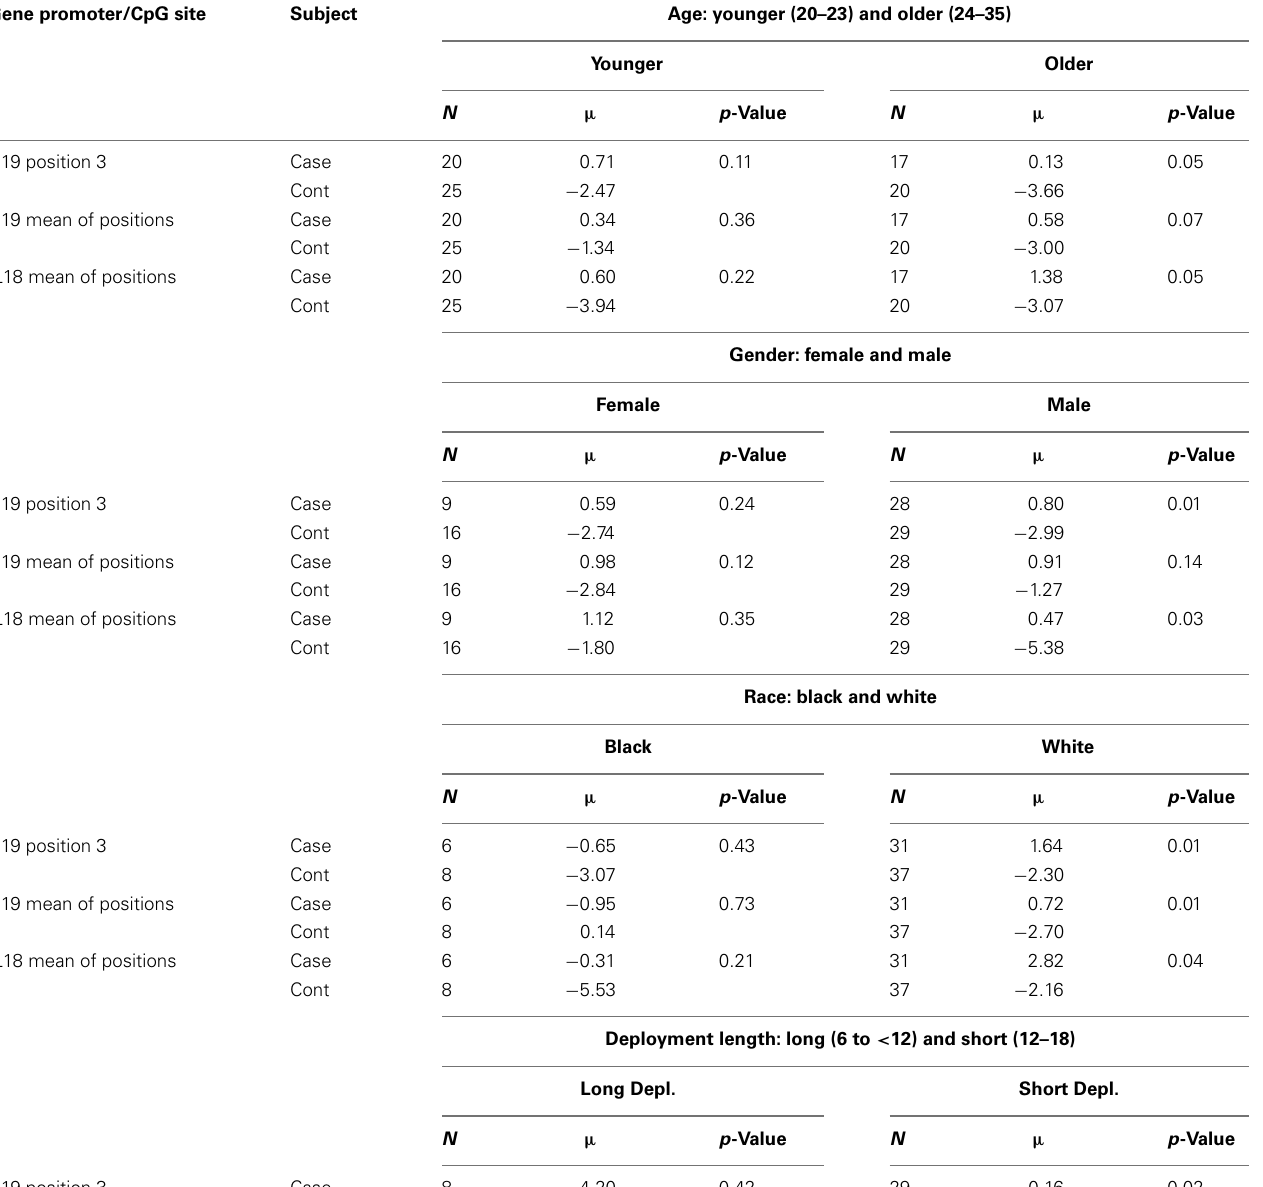
Table 3 | MultivariateANOVA comparing adjusted * mean of pre-post methylation difference for cases versus controls, stratified by age, gender, race, and deployment